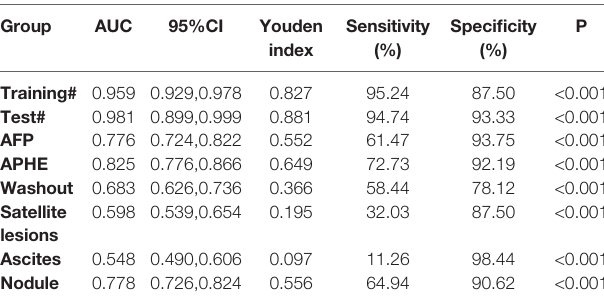
TABLE 4 | Results of receiver operating characteristic (ROC)